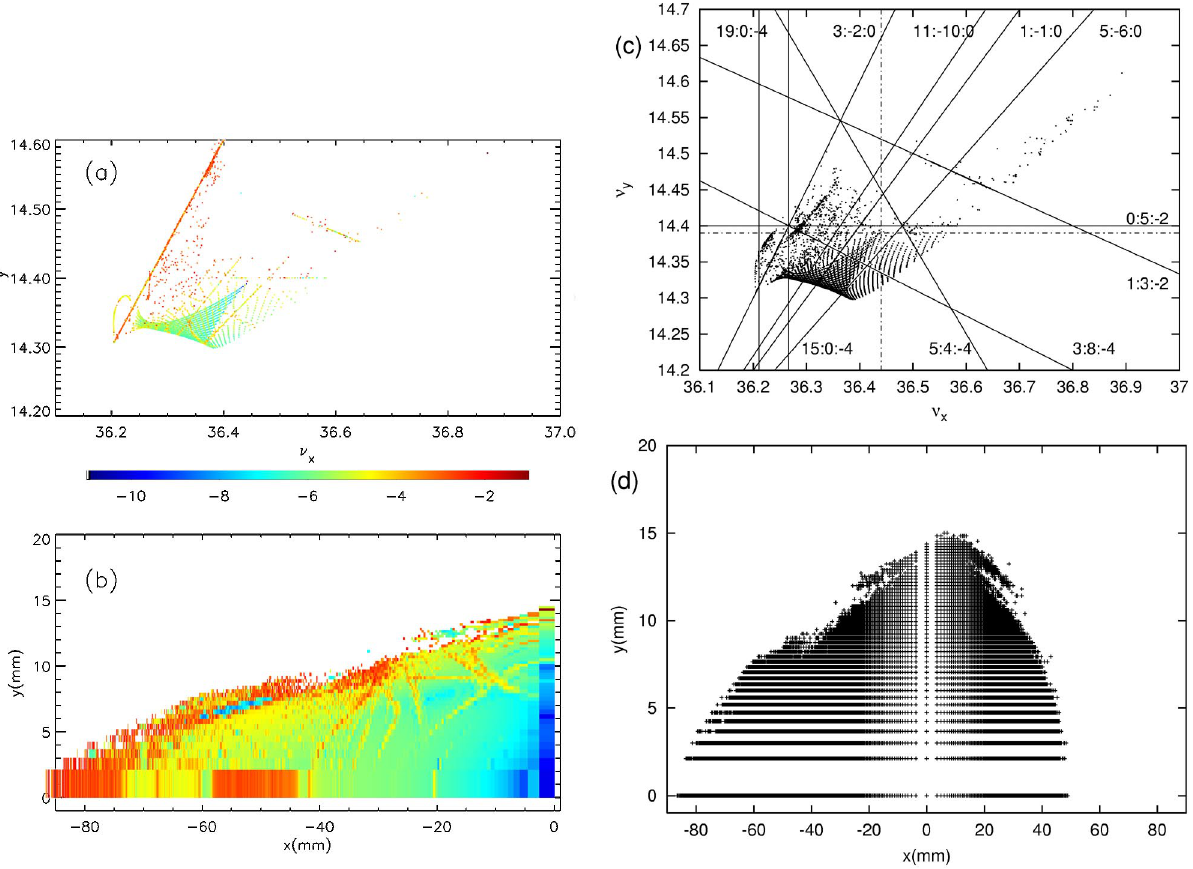
FIG. 11. (Color) ESRF frequency map (a) and dynamic aperture (b) for the second sextupole set computed for the Poincare´ surface (cid:1) 35 : 6 m and (cid:28) (cid:1) 2 : 5 m ). Resonance identification (c) and full dynamics aperture (d): The working point is shown as a s (cid:1) 0 ( (cid:28) x y dashed line cross. The main resonance 3: (cid:12) 2:0 is now reached at a larger amplitude. As a result, the dynamics is globally